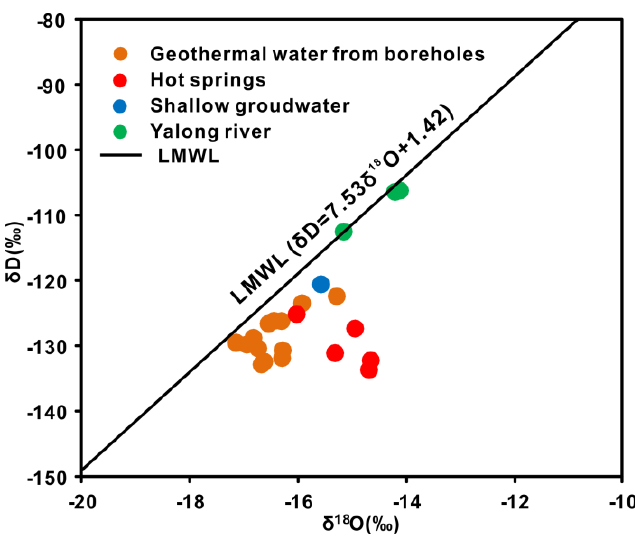
Figure 2. δD vs δ 18 O plot shows the isotopic composition of all water samples from the Ganzi geothermal field. LMWL stands for the local meteoric water line (δD = 7.53δ 18 O + 1.42) in Chengdu, Sichuan province [33].